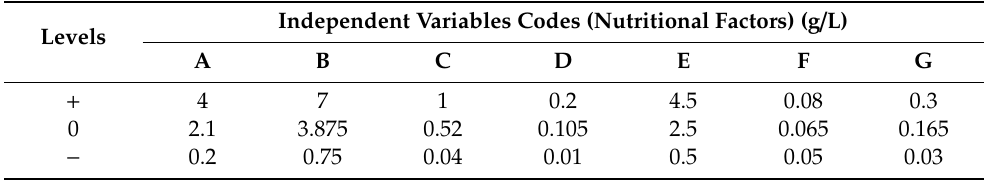
Table 6. Plackett–Burman Design with low ( − ) and high ( + ) levels together with one center point array (0) for seven nutritional factors in modified BH medium. Independent Variables Codes (Nutritional Factors) (g / L) Levels A